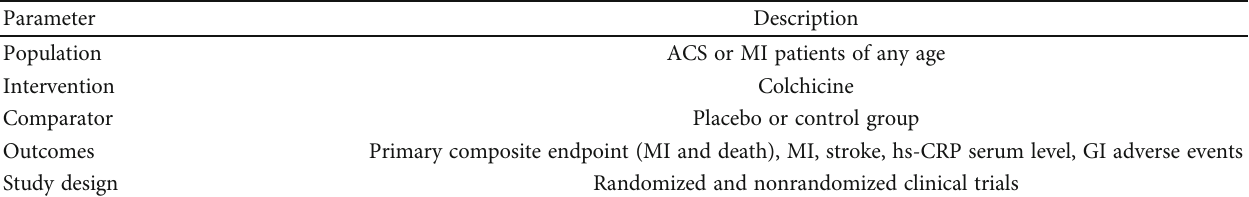
Table 1: Summary of the PICOS criteria used to identify relevant